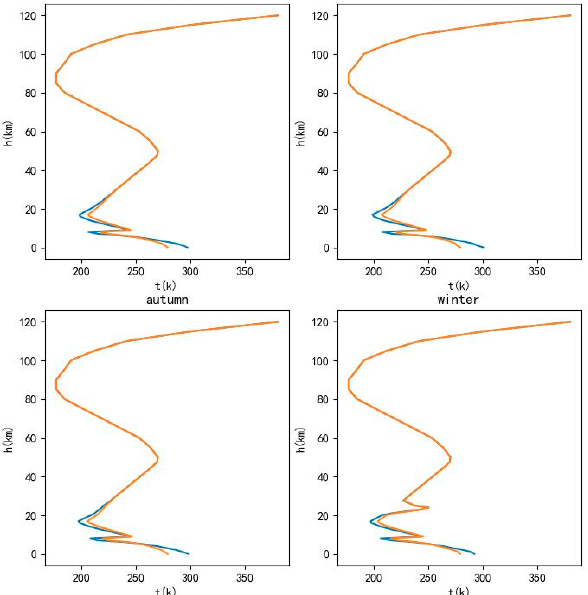
Figure 23. Temperature profile reconstruction results (yellow curve—profile before correction, blue curve—profile after correction).